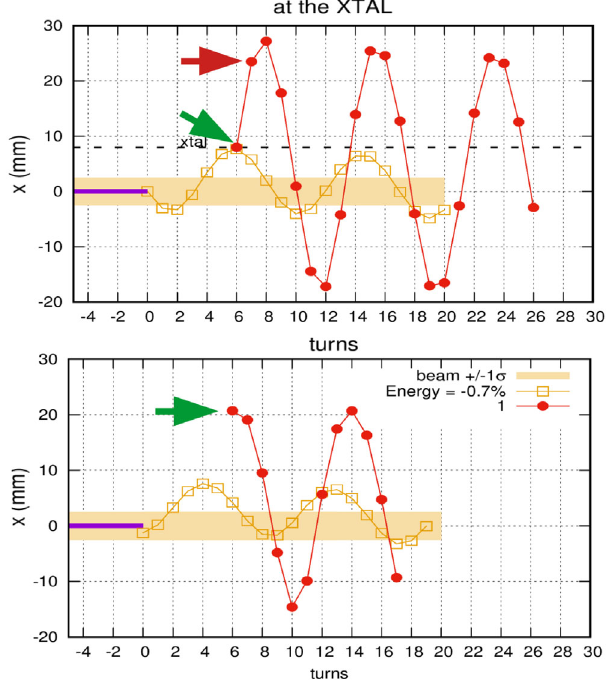
FIG. 9. Turn by turn single particle tracking results seen at the crystal location (top) and the extraction septum (bottom). The particle trajectory is initially set to zero position and angle and at turn zero it loses 0.7% of its energy. At turn 6 it interacts with the crystal and it reaches 20 mm of displacement at the septum. If not extracted, the particle continues to oscillate with a large